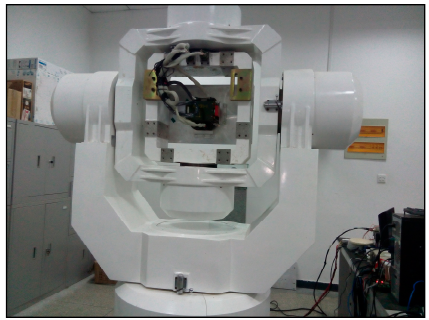
Figure 11. Three-axis turntable.